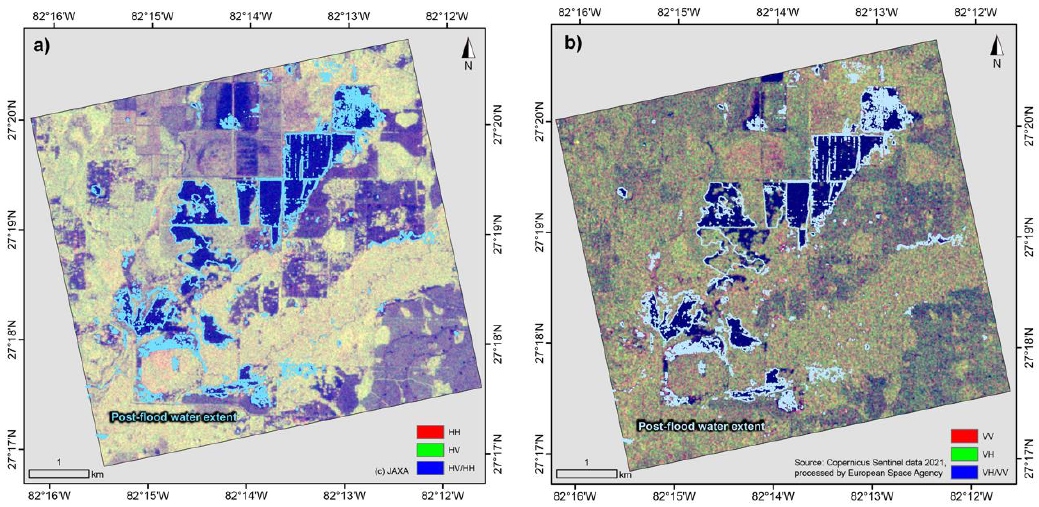
Figure 3. Optically derived water extent ( a ) after flood (12 September 2017) and ( b ) in general status shown in WF. ID numbers are assigned in representative six post-flood water bodies. Contour lines in black denote an example coastline of usual water extent (>0.2).